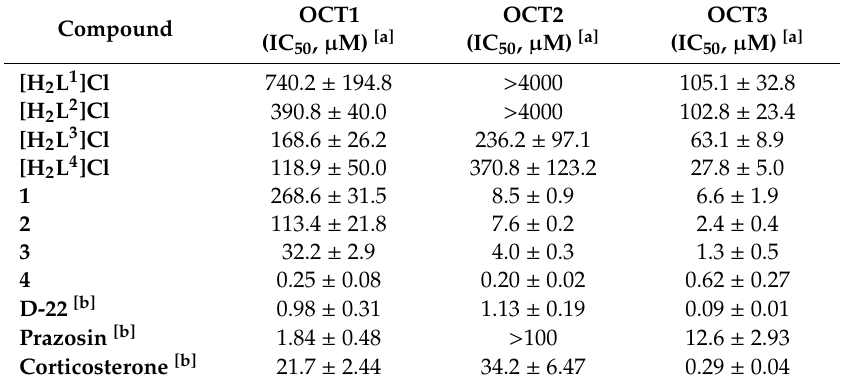
Table 4. [ 3 H]-MPP + uptake inhibition by [H 2 L 1 − 4 ]Cl and 1 – 4 in HEK OCT1–3